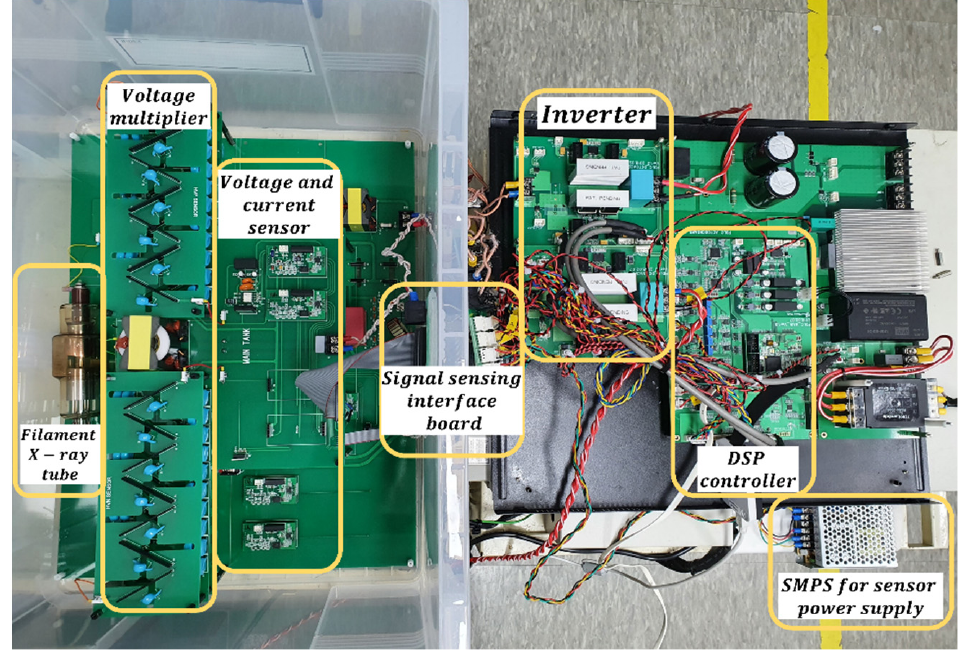
Figure 6. Experimental setup for comparison of the conventional current control with the proposed temperature control.